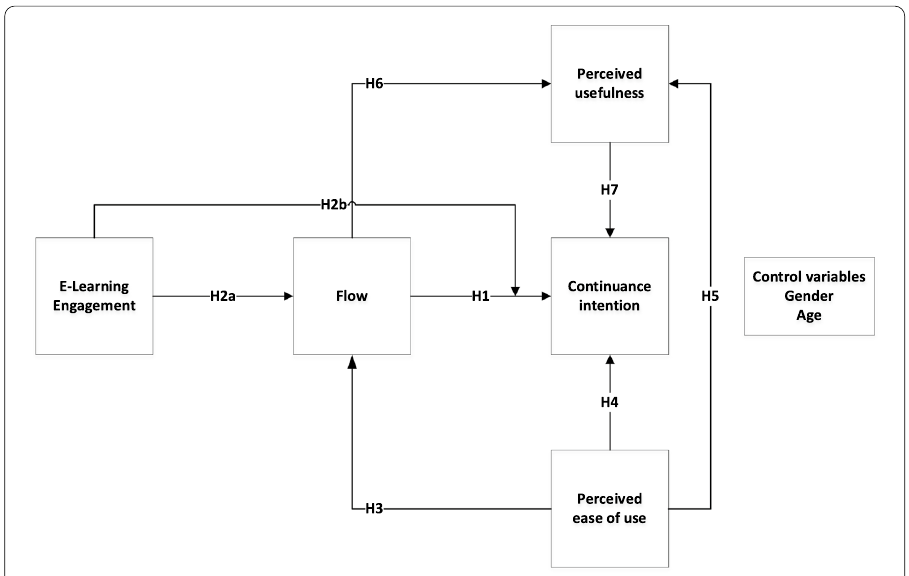
Fig. 1 Mediated moderation research